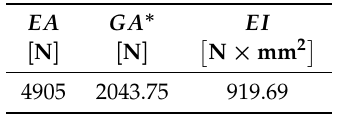
Table 1. Elasto-geometric properties of the fibers for the case studies I and II.